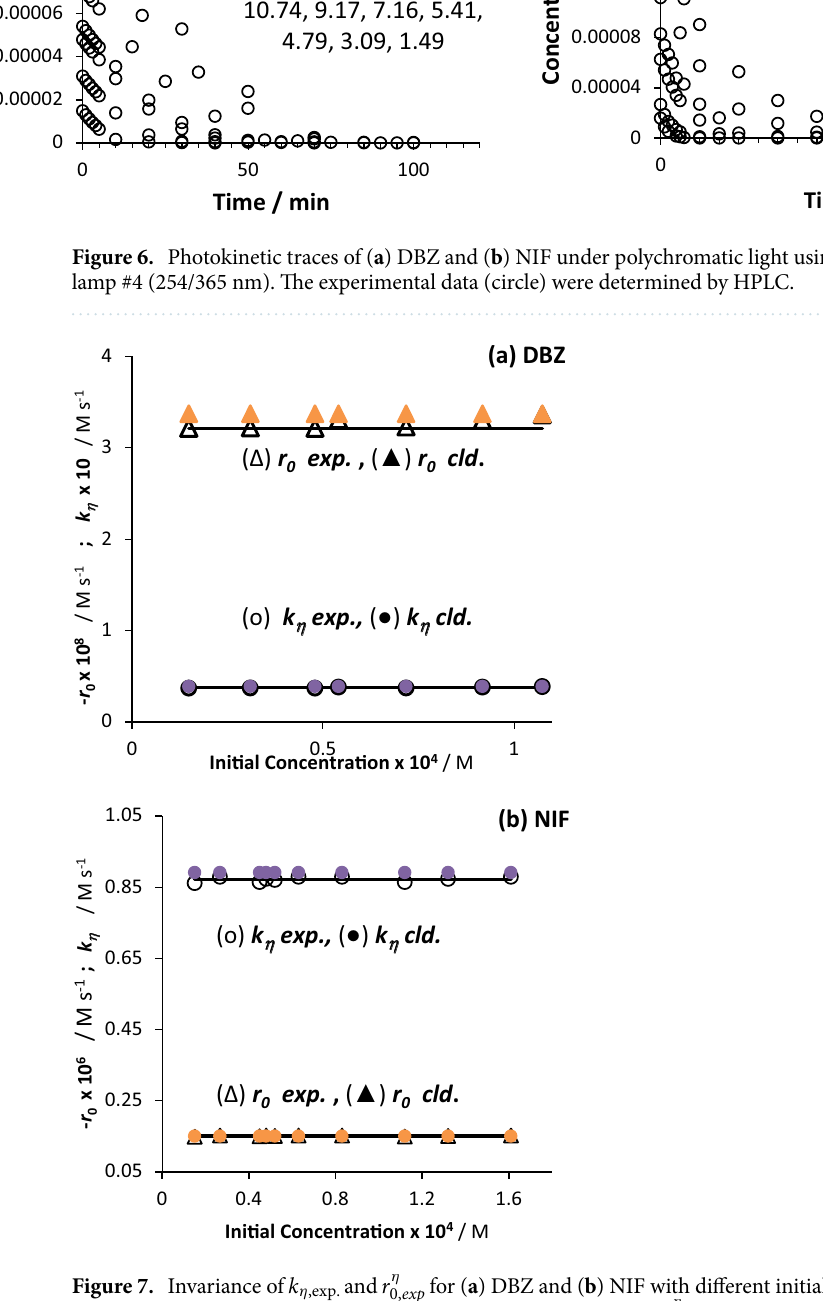
Figure 7. Invariance of k η ,exp. and r The solid symbols correspond to the calculated values of k η , cld . and r ± 1σ of 0.007 and 0.06 for DBZ, and 0.0012 and 0.007 for